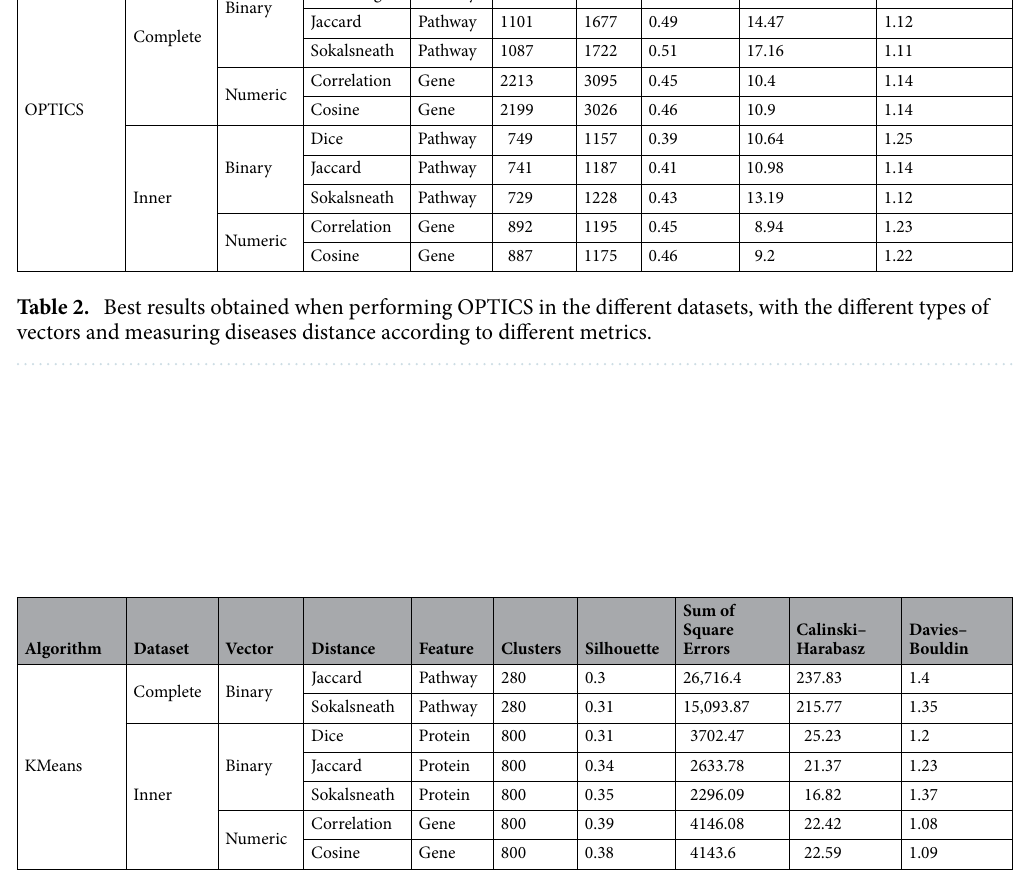
Table 3. Best results obtained when performing KMeans in the different datasets, with the different types of vectors and measuring diseases distance according to different metrics.